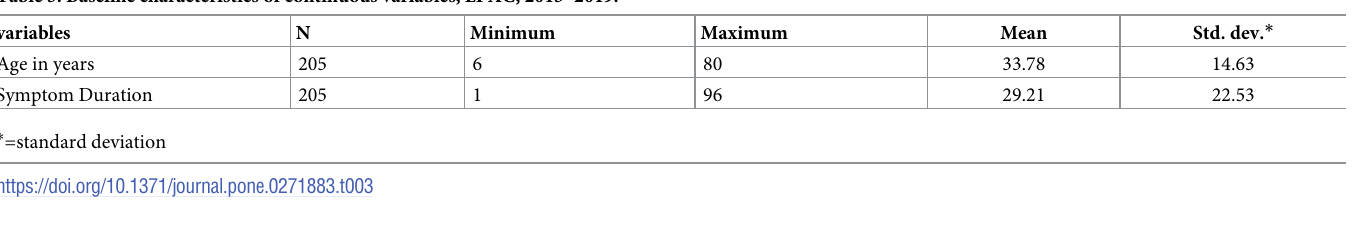
Table 3. Baseline characteristics of continuous variables, LPAC,